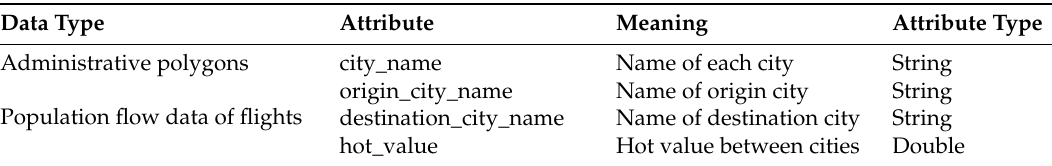
Table 1. Data attributes